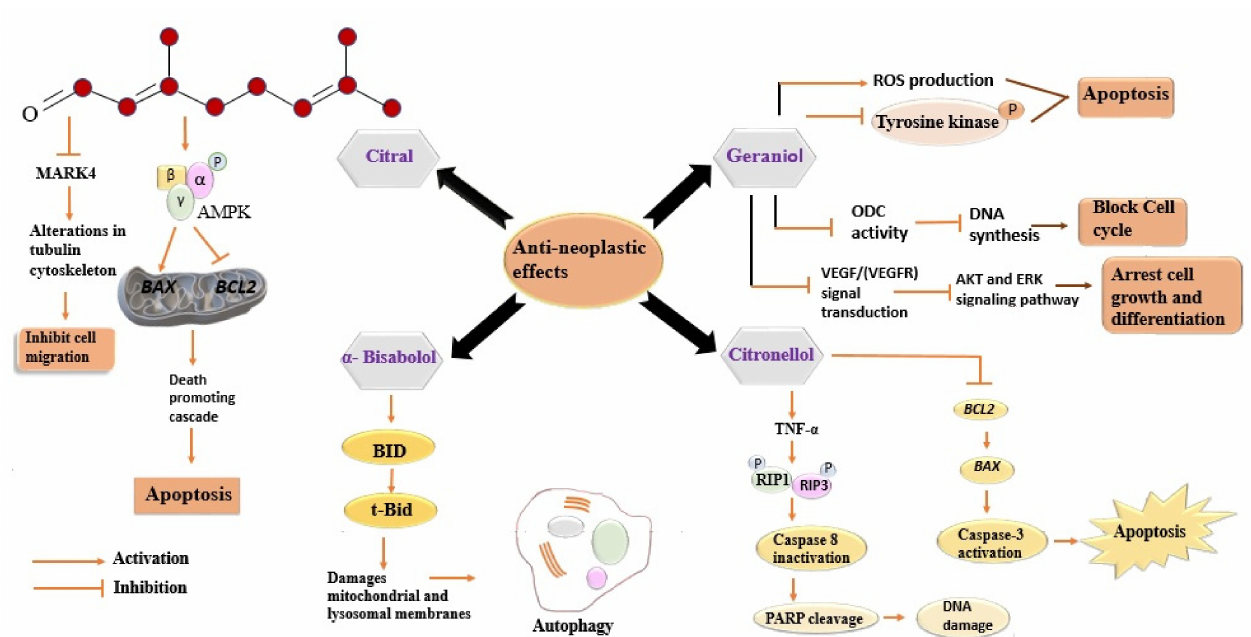
Figure 4. Distinctive signalling pathways activated in cancer cells via different components of LEO. Every component acts differently against cancer cells and involves diverse signalling pathways. All the involved pathways lead to inhibition of cell migration, cell cycle, and DNA synthesis. All these events eventually cause cell death (apoptosis). MARK4, Microtubule affinity-regulating kinase 4; AMPK, 5 (cid:48) adenosine monophosphate-activated protein kinase; BAX, BCl2- associated X protein; BCL2, B-cell lymphoma 2; BID, BH3-only activator protein; tBid, truncated Bid, ROS, reactive oxygen species; ODC, ornithine decarboxylase; VEGF, vascular endothelial growth factor; VEGFR, vascular endothelial growth factor receptor; AKT, Ak strain transforming; ERK, extracellular regulated kinase; TNF- α , tumour necrosis factor; RIP1, receptor-interacting serine-threonine protein kinase 1; RIP3, receptor-interacting serine-threonine protein kinase 3; PARP, poly ADP ribose polymerase; DNA, deoxyribonucleic